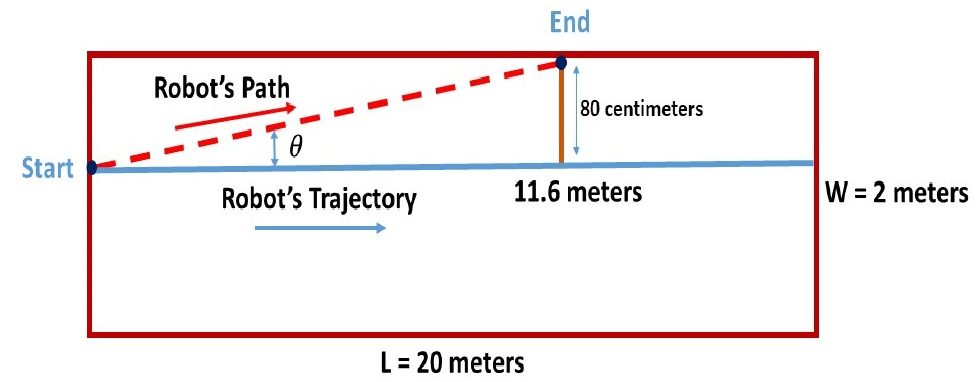
Figure 2. The diagram of the straight line test.